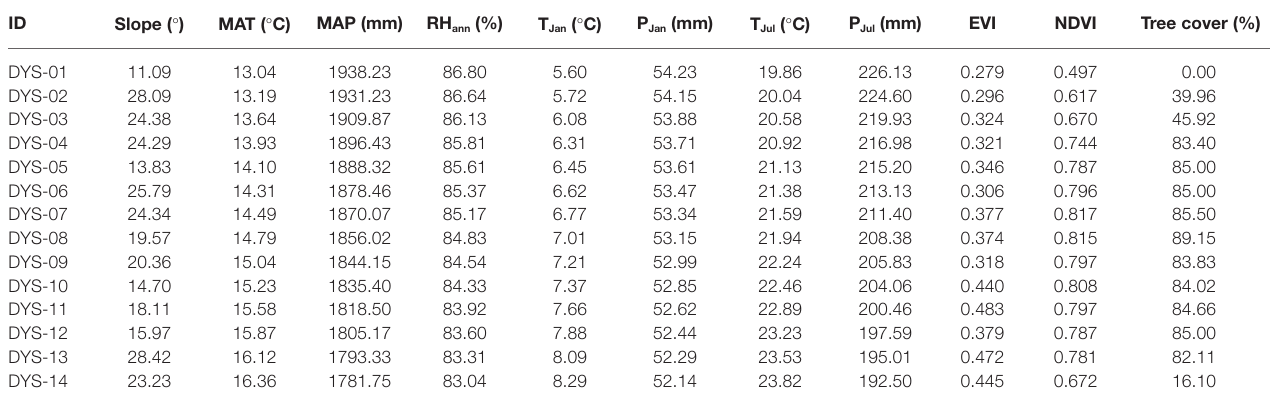
TABLE 2 | Climate parameters and vegetation indices for samples collected along an elevation gradient in the Daiyun Mountains, southeastern China. ID Slope ( °